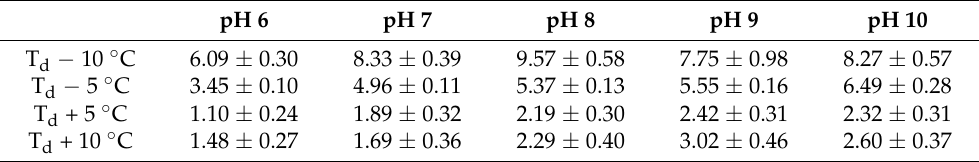
Figure 3. Arrhenius diagram of the PPI denaturation reaction rate. The reaction rate is obtained by fitting Equation (3) to the data presented in Figure 2. For temperatures 10 °C below the respective denaturation temperature, a deviation from the linear behavior is observed. The dashed line is meant as a guide for the eye. Table 2. Reaction order of the denaturation of a PPI solution in dependence of temperature and